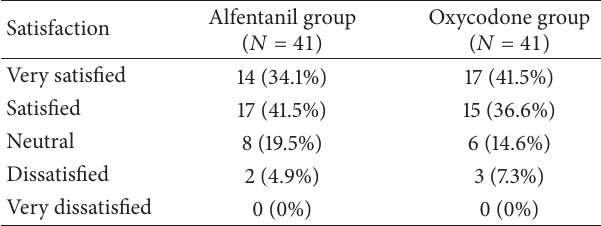
Table 4: Satisfaction of patients at the postoperative 48 hours.